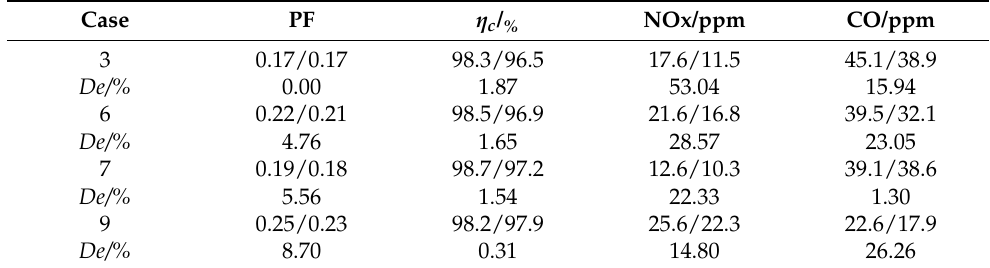
Table 4. A comparison of the combustion characteristics between the experiment and numerical cal- culation ( De is the ratio of the difference between the calculation and test results with the test results). Case PF η c / %